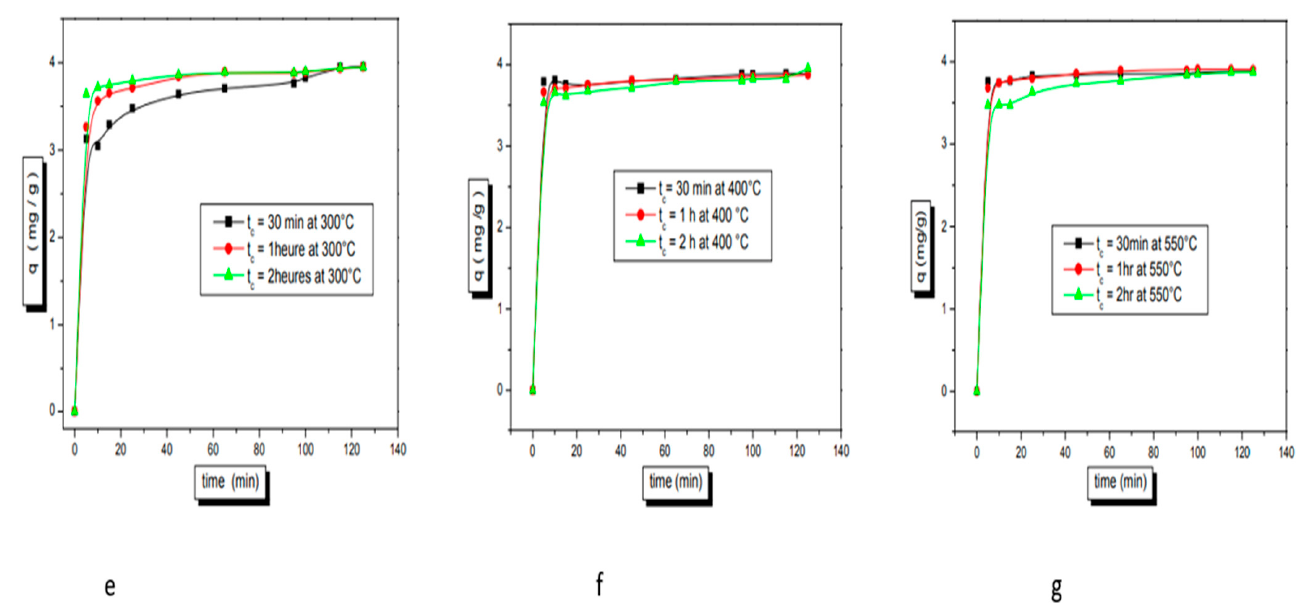
Figure 6. ( a ) FTIR of raw orange peel, ( b ) Calcined at 300 °C, ( c ) 400 °C, ( d ) 550 °C, ( e – g ) Effects of Figure 6. ( A ) FTIR of raw orange peel, ( B ) Calcined at 300 ◦ C, ( C ) 400 ◦ C, ( D ) 550 ◦ C, ( e – g ) Effects of time on adsorption capacities of OP calcined at different temperatures [101]. time on adsorption capacities of OP calcined at different temperatures